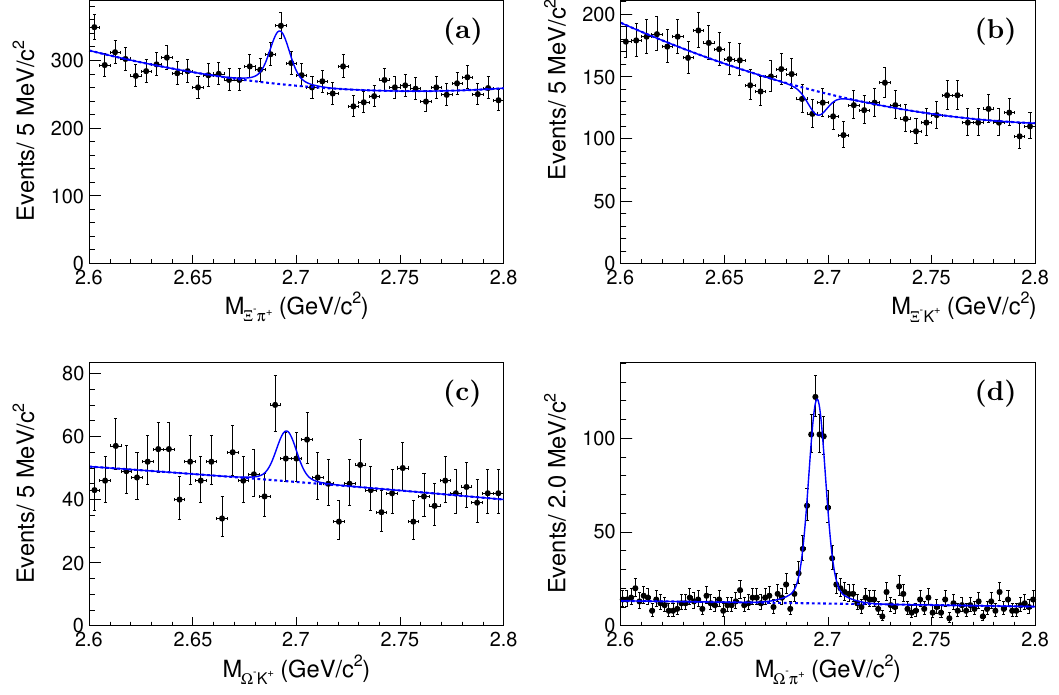
Figure 2 . The invariant mass distributions of (a) Ξ − π + , (b) Ξ − K + , (c) Ω − K + , and (d) Ω − π + from data samples. The solid curves are the best fits, and the dashed curves are the fitted